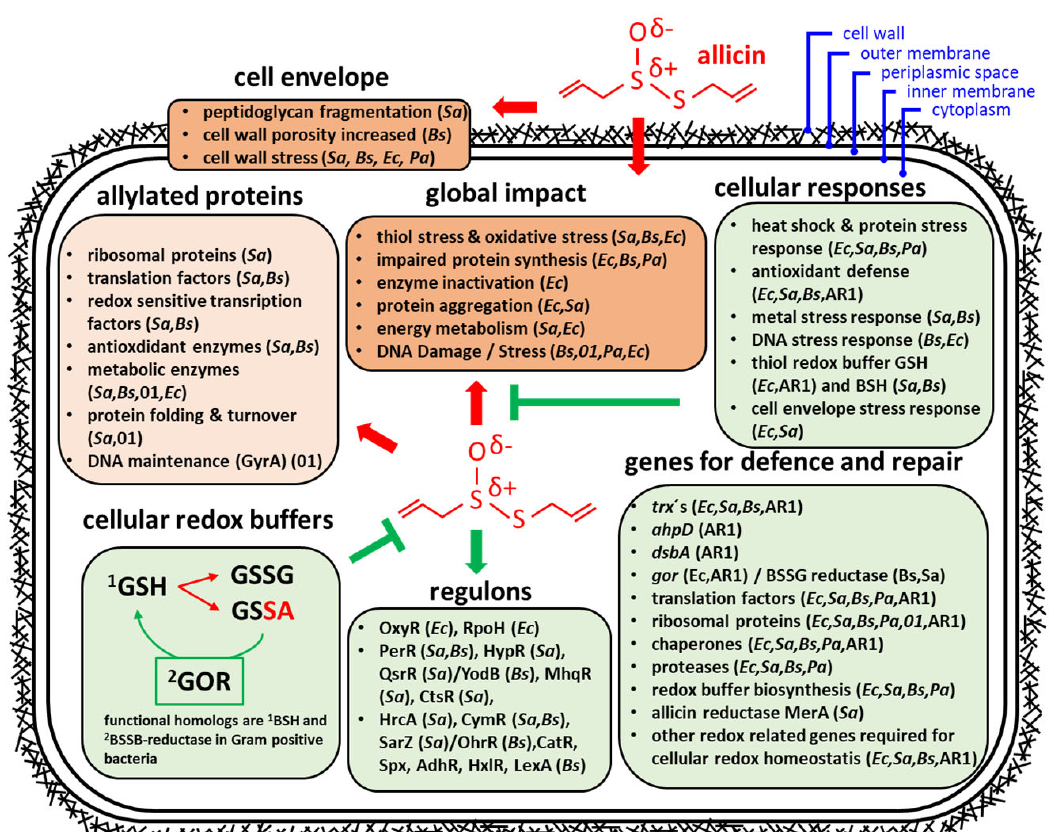
Figure 4. Summary of some of the effects of allicin on bacterial cells. The bacteria are: Ec = E. coli K12 [31,78], Sa = S. aureus USA300 [59,80,87], Bs = Bacillus subtilis strain 168 [60,78], Pa = Pseudomonas aeruginosa PA01 [78], 01 = P. fluorescens 01 [88], AR1 = P. fluorescens AR1 [77]. Abbreviations are: Trx = thioredoxin; AhpD = alkylhydroperoxidase D; DsbA = disulfide bond protein A; GSH = glutathione; GSSG = glutathione disulfide; GSSA = S -allylmercaptoglutathione; BSH = bacillithiol; BSSB = bacillithiol disulfide; Gor = glutathione disulfide reductase; GyrA = DNA gyrase subunit A. The heat and oxidative stress regulons induced under allicin stress in different bacteria are indicated, that are either regulated by S -thioallylation of the redox-sensitive regulators (YodB, OhrR, HypR, CatR) or by other mechanisms, such as increased oxidatively damaged proteins (e.g., RpoH, HrcA, CtsR). Background information about the functions of the transcription factors and their regulons is given in Table S1.